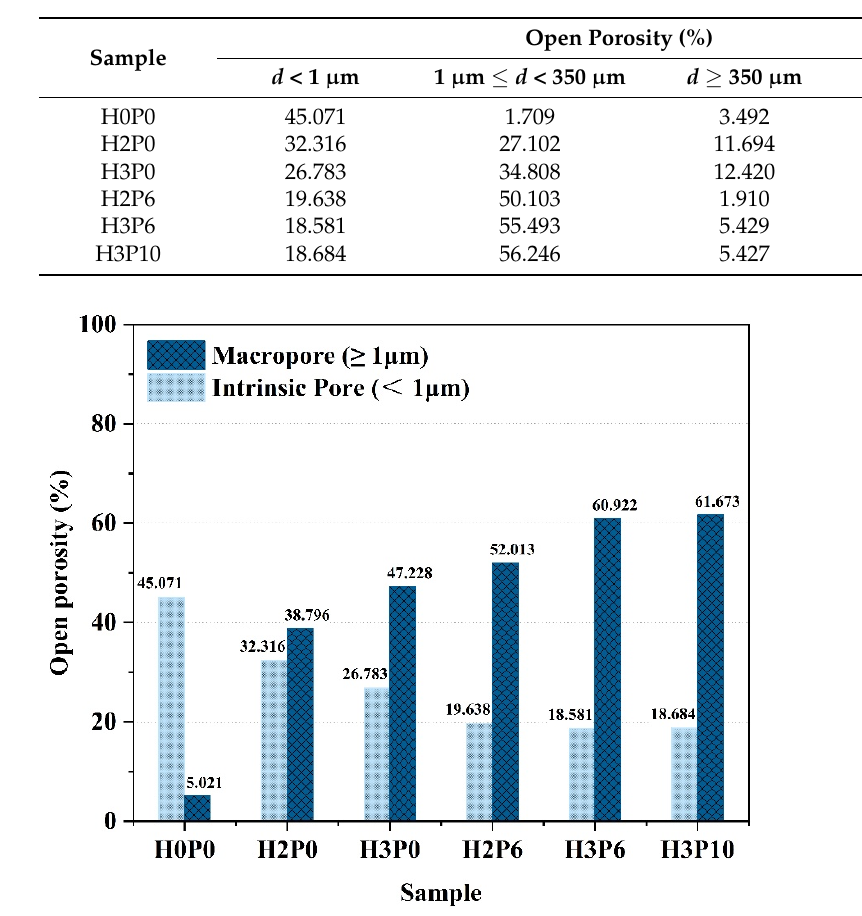
Table 5. Graded open porosity of geopolymer foams.